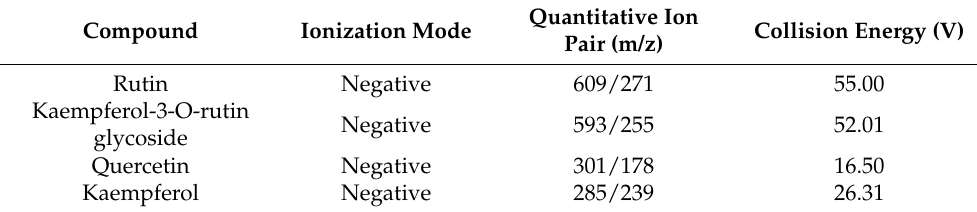
Table 5. Parameters of components to be measured by mass